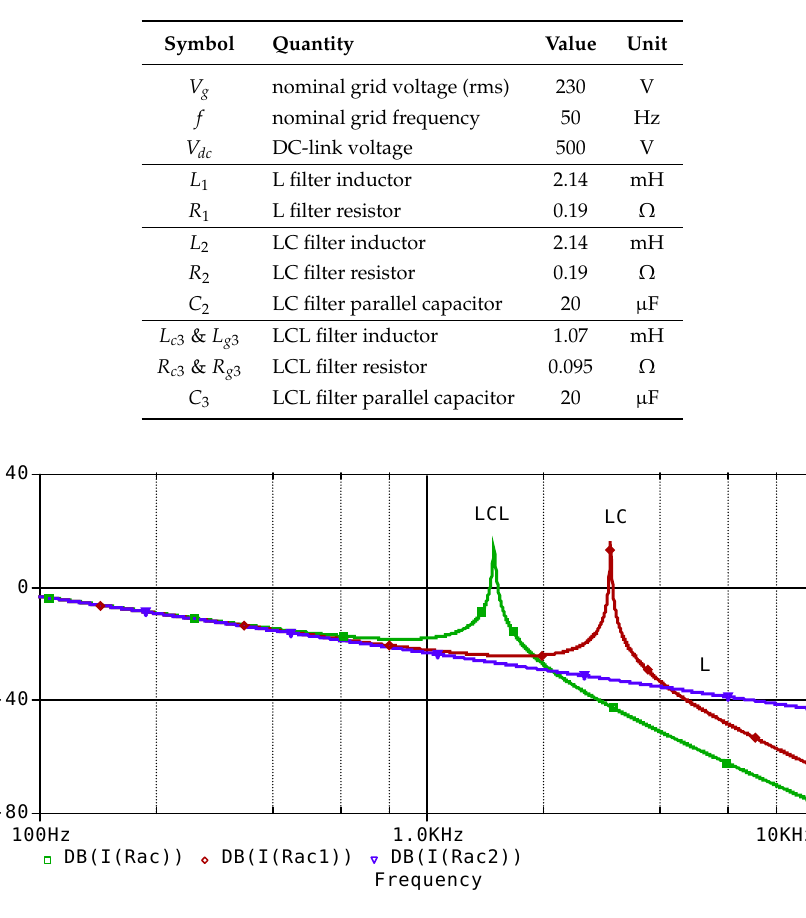
Figure 6. Frequency response of three different filters.